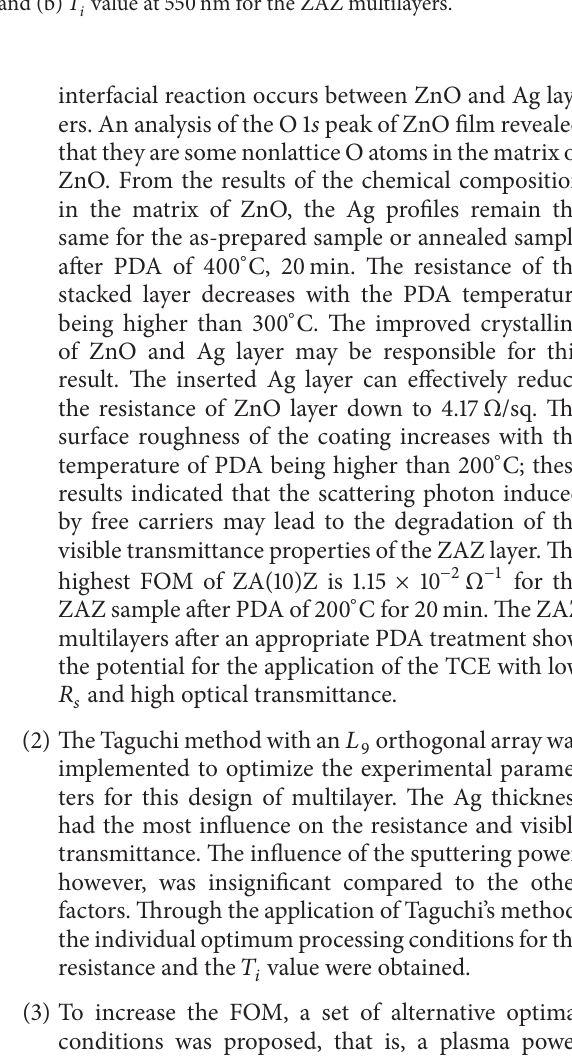
Figure 11: Response graphs of 𝑆/𝑁 ratios for (a) resistance and (b) 𝑇 𝑖 value at 550 nm for the ZAZ multilayers.